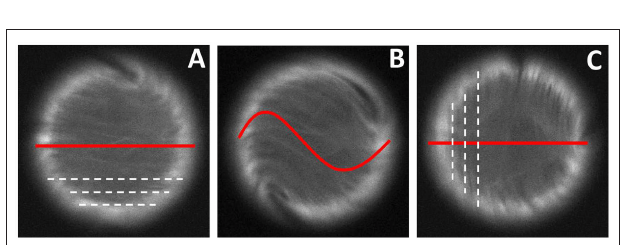
FIGURE 5 | Coordination between the SR and AN orientation during synchronized oscillations. Fluorescence micrographs with three snapshots of the AN oscillation. The SR is sketched as a red line. The dashed lines in (A) and (C) represent the two complementary states of the active shell where filaments are aligned, while panel (B) includes the distorted SR configuration. The droplet has a diameter of 80 µ m.